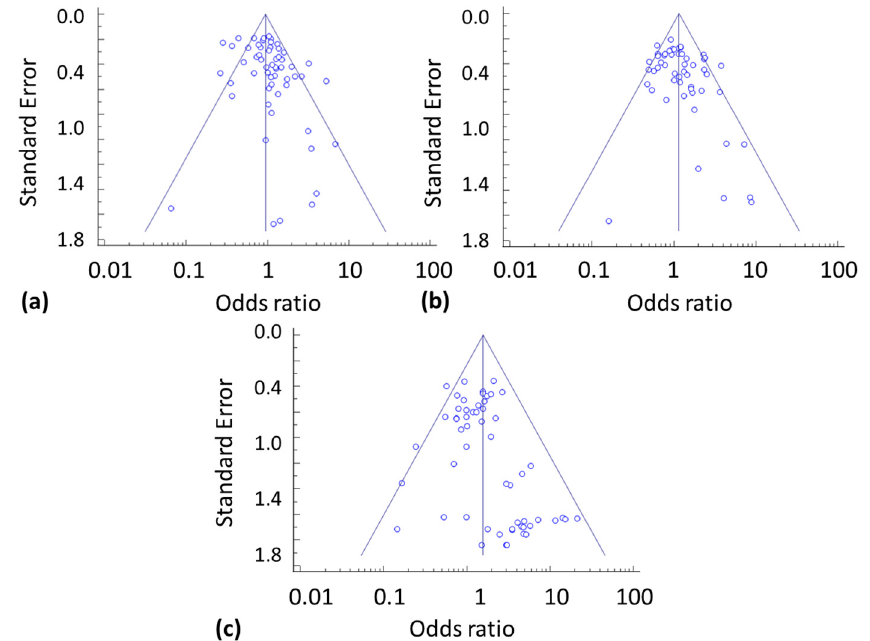
Figure 3. Funnel plots on the reporting of selected adverse events in placebo groups, showing the effect size (odds ratio) as a function of included studies (natural log of standard error). A publication bias has to be suggested for ( a ) nausea but not for ( b ) diarrhoea and ( c ) serious infections and infes- tations.